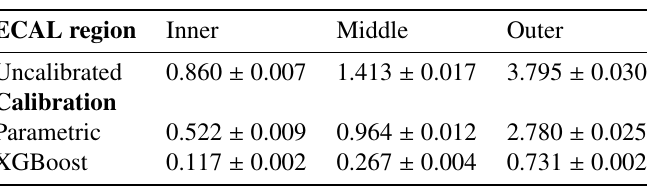
Table 1. Spatial reconstruction results (RMSE, cm) of local coordinate x for uncalibrated data, and for the data calibrated using parametric approach and XGBoost regressor.